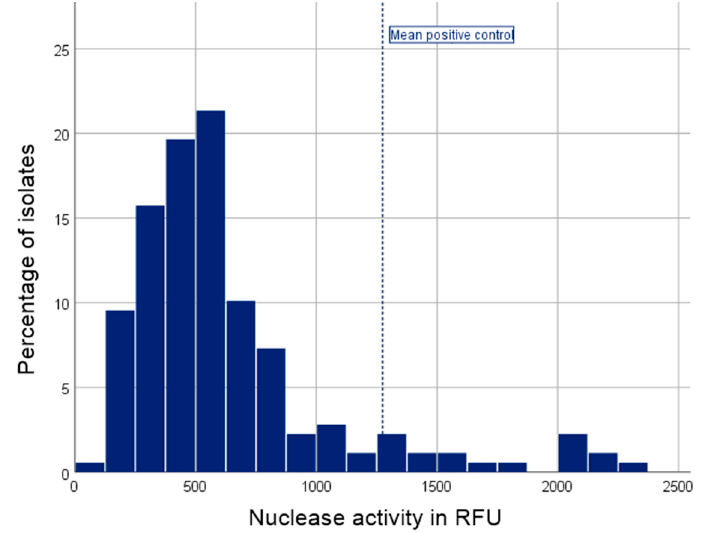
Figure 1. Histogram of the nuclease activity assay results. Nuclease activity was highly variable, but present in all isolates. Median nuclease activity was 528.6 RFU (IQR 358.8–743.9 RFU). The positive control showed a mean nuclease activity of 1274.4 RFU; RFU = relative fluorescence units.